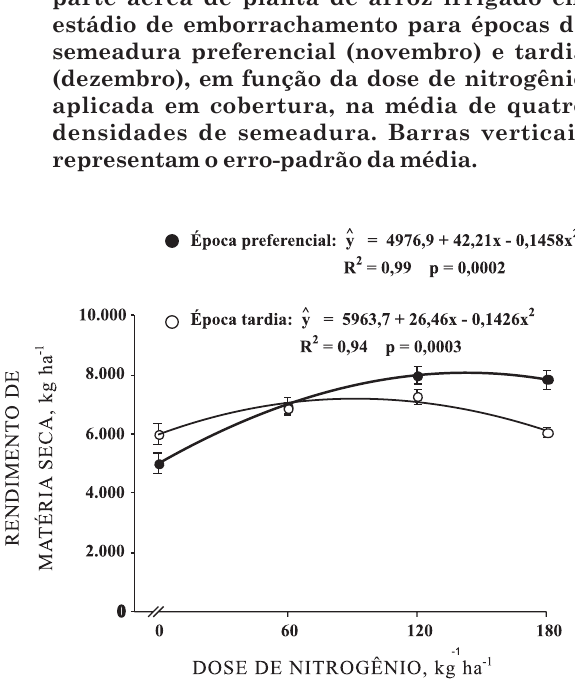
Figura 2. Rendimento de matéria seca da parte aérea de planta de arroz irrigado em estádio de colheita para épocas de semeadura preferencial (novembro) e tardia (dezembro), em função de dose de nitrogênio aplicado em cobertura, na média de quatro densidades de semeadura. Barras verticais representam o erro-padrão da